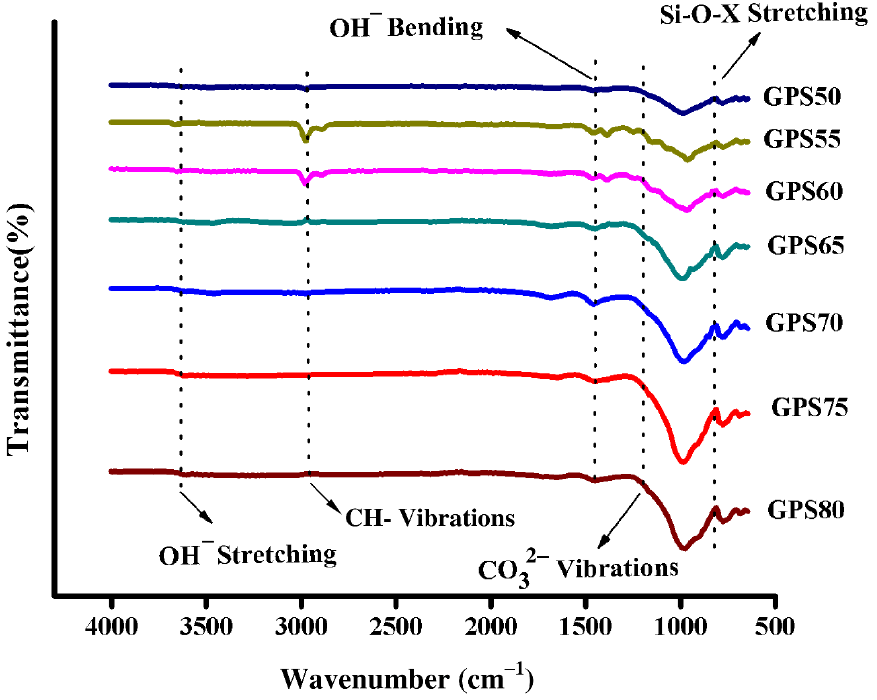
Figure 4. FTIR spectra of GP samples.